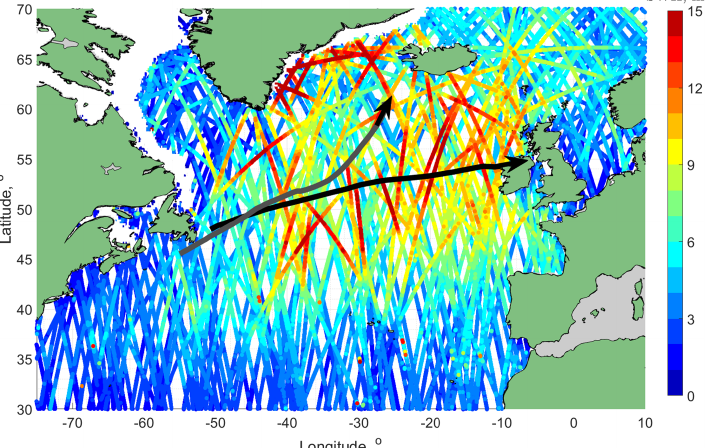
Figure 3. Altimetry tracks passing through the Northern Atlantic during the period of 11 February 2020 00:00 UTC–16 February 2020 00:00 UTC, after applying ice and land masks. The black line shows the trajectory of the ETC#1 and the gray line ETC#2. The colour of the altimeter tracks indicates measured SWH in meters.